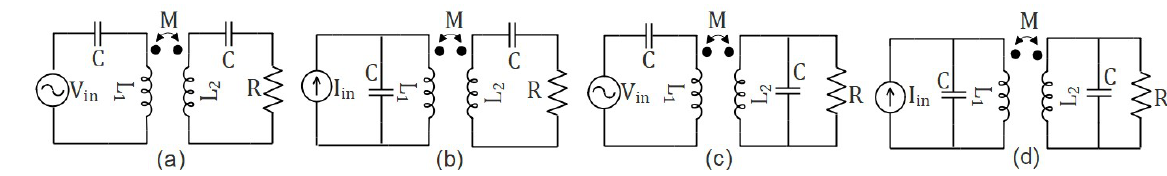
Figure 2. Types of compensation networks: ( a ) series–series, ( b ) parallel–series, ( c ) series–parallel and ( d )